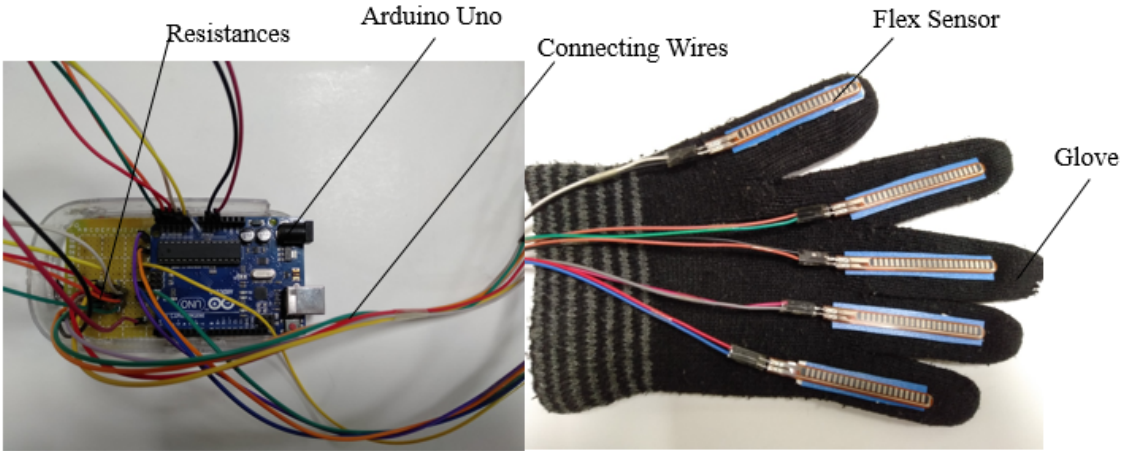
Figure 2. Flex sensor, gyroscope, and Arduino-based data glove designed for capturing ASL-based gestures.